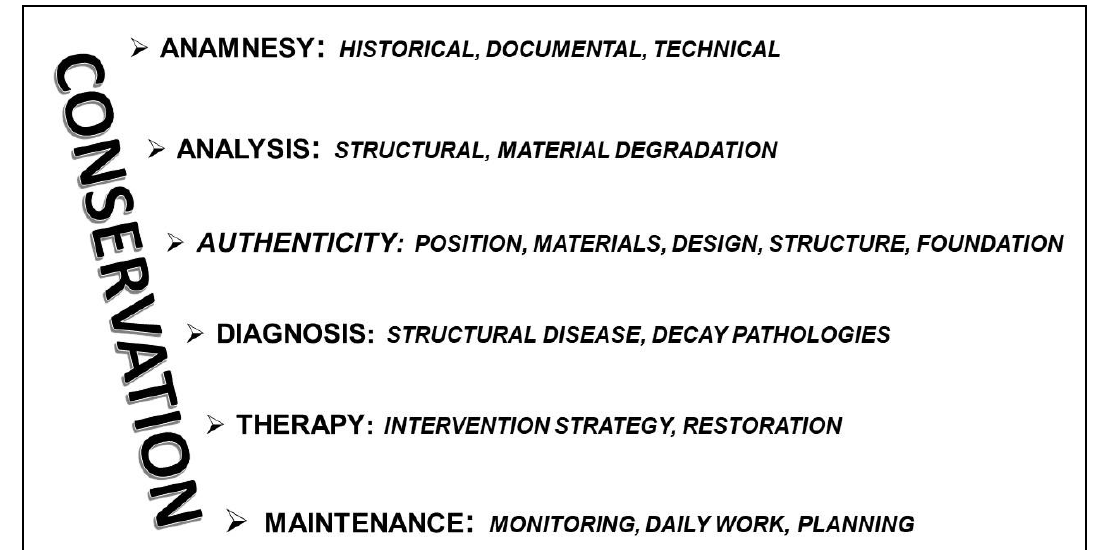
Figure 2. Virtuous chain for a typical conservation of cultural heritage buildings.